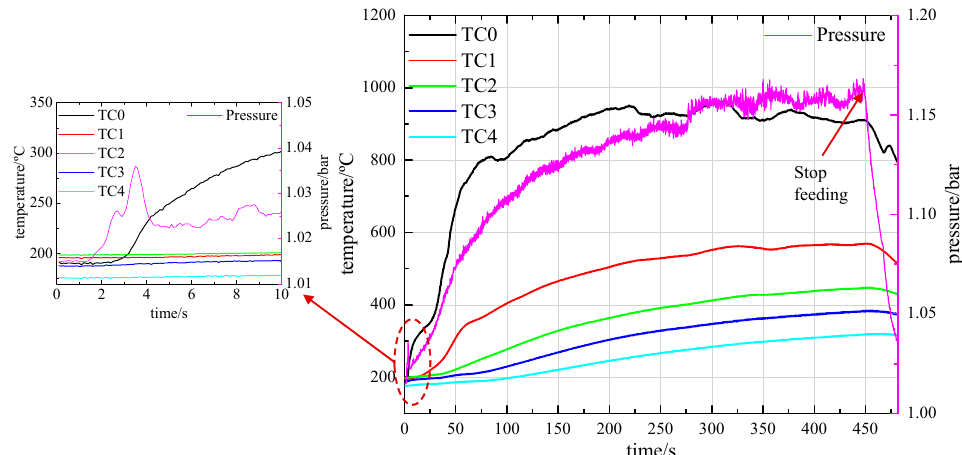
Figure 6. Temperature and pressure curves of a model thruster with the convergent nozzle at 1 mL/min flow rate.